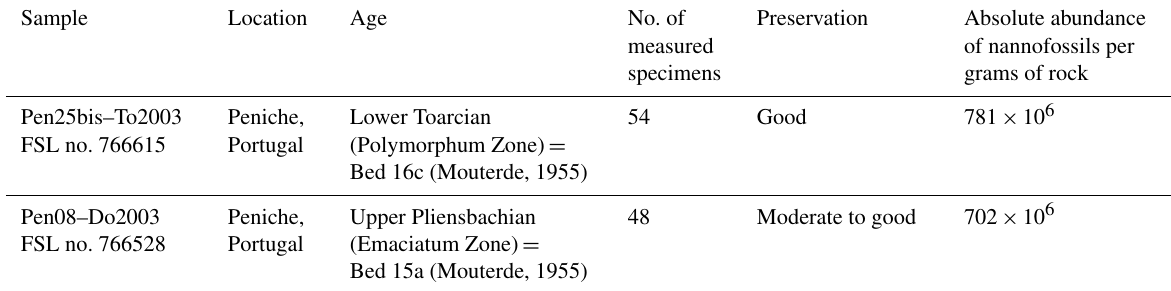
Table 1. Stratigraphic information of the studied samples. Repository: Collections de Géologie de Lyon.